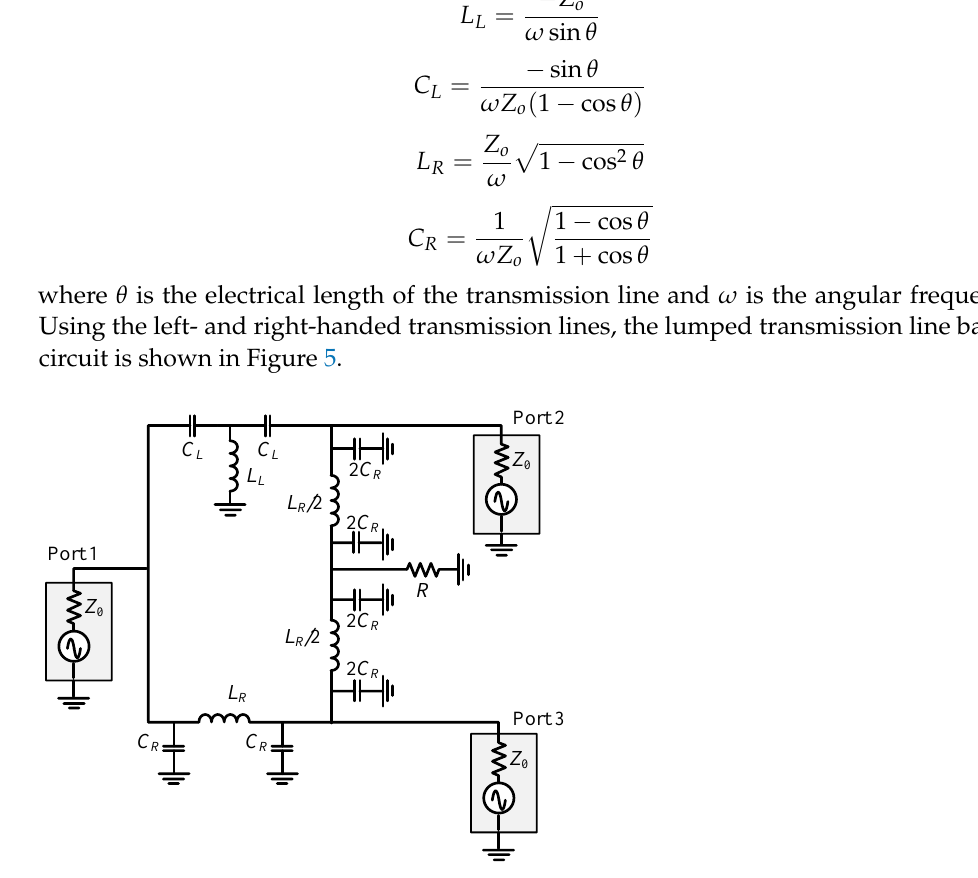
Figure 5. Schematic of conventional lumped transmission line balun.